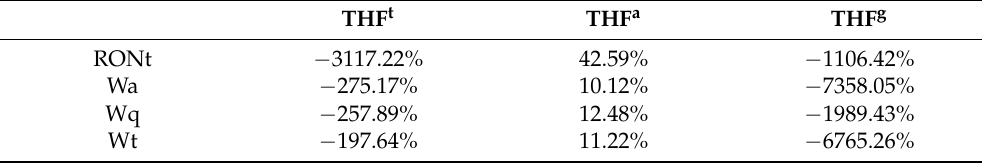
Table 2. Technological heredity coefficients determined for the waviness of the inner ring surface.